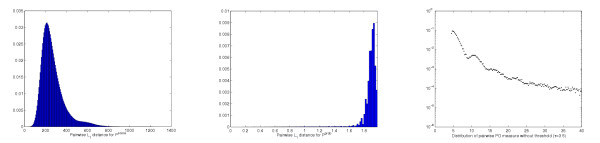
Left: Distribution of pairwise distances between feature vectors Pscore (τ= 3.5, L1 metric). Middle: Distribution of pairwise distances between feature vectors Pprob (τ= 3.5, L1 metric, distance 2 ignored). Right: Distribution of the PD measure for feature vectors Ppvalue (τ= 3.5). The last distribution is plotted in logscale for distances smaller than 40.